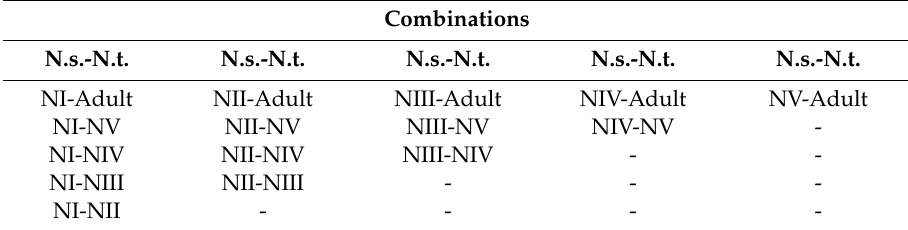
Table A3. Combinations used in the IGP N. pseudoferus – N. tenuis , assay 2, under laboratory conditions and without alternative prey, when N. pseudoferus was always in a lower stage class than N. tenuis